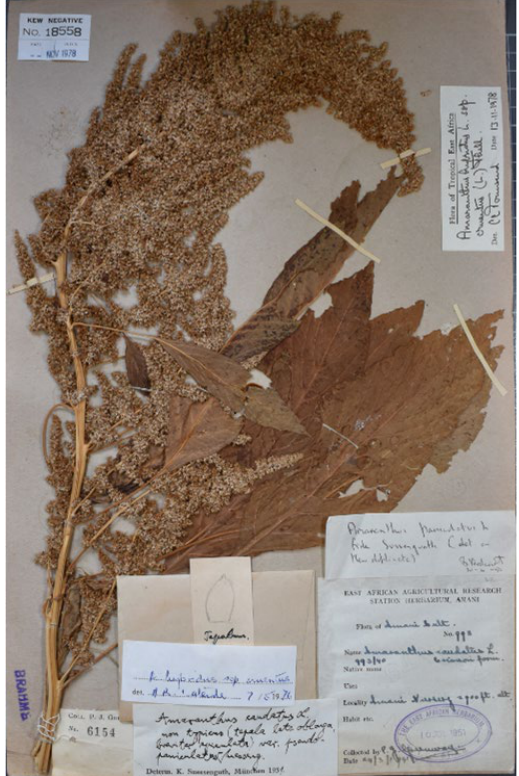
Figure 2. Holotype of Amaranthus caudatus var. pseudopaniculatus f. pseudopaniculatus (EA no. 6154).